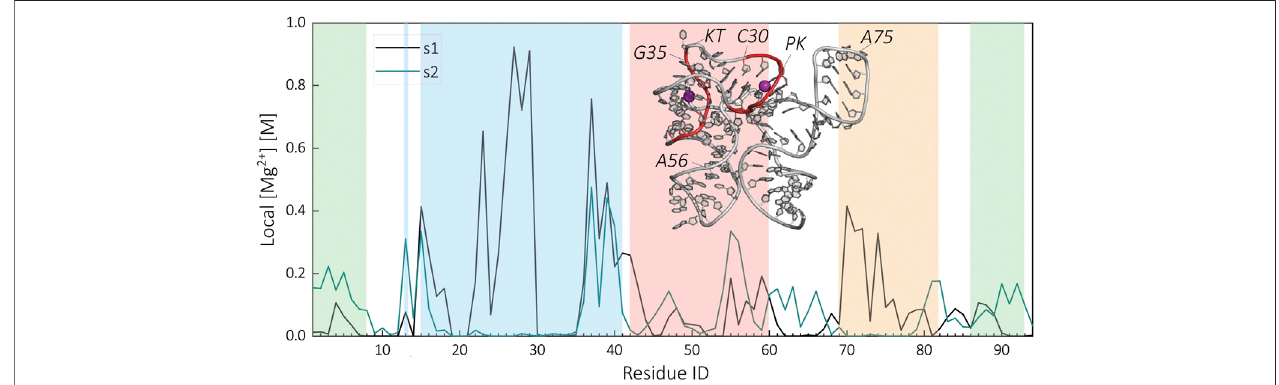
FIGURE 6 | Comparison of the residue level local Mg 2+ concentration at the ligand-bound (s1) and apo-state (s2) of the SAM-I riboswitch. The regions of the riboswitcharehighlightedincolor,P1(green), P2(blue), P3(red), and P4(orange). Theinsertedstructuralrepresentation ofs1highlightsthelocationofthetwoidenti fi ed Mg 2+ binding sites within the helix P2.